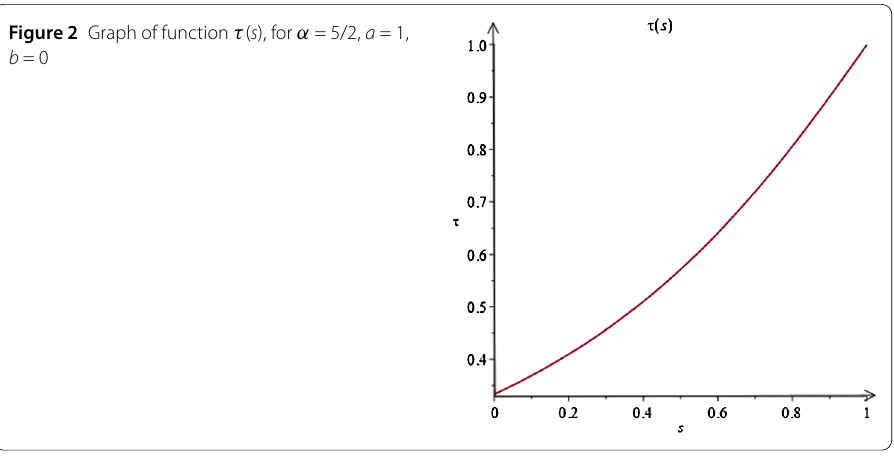
Figure 2 Graph of function τ ( s ), for α = 5/2, a = 1,